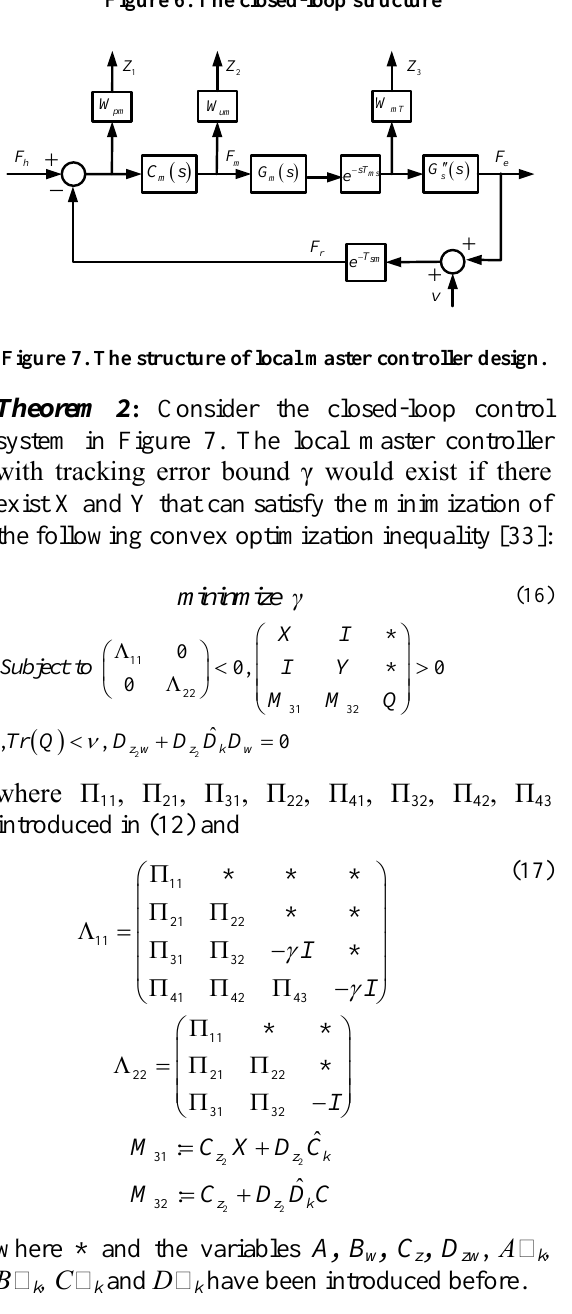
Figure 6. The closed-loop structure